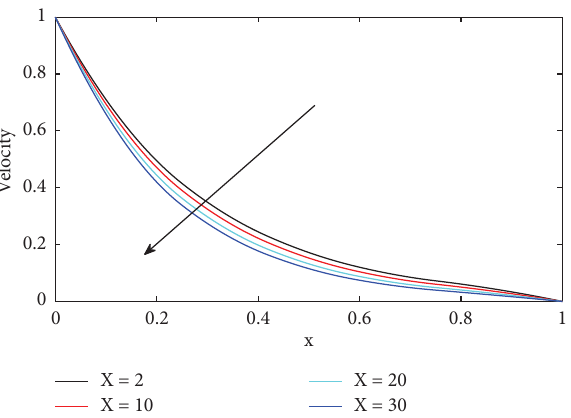
Figure 5: Velocity profles for diferent values of X .